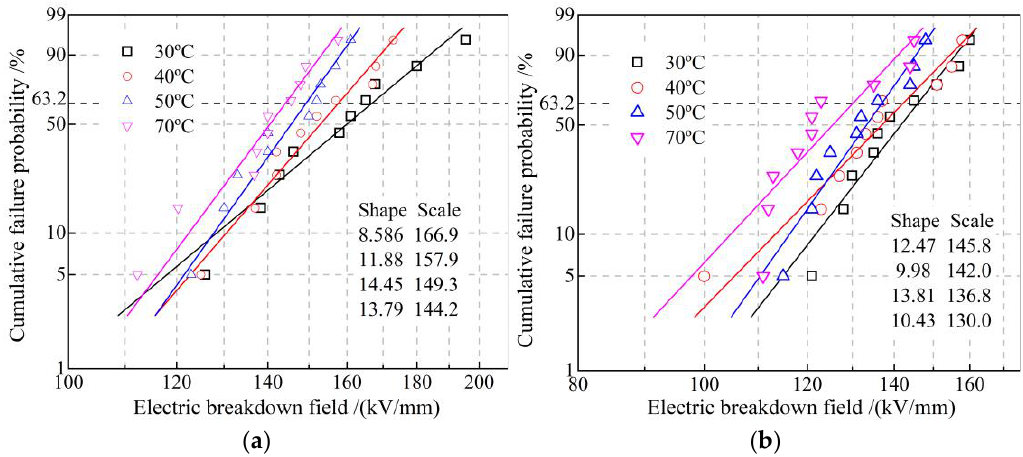
Figure 9. DC electric-breakdown fields fitted in Weibull statistics of ( a ) EPDM and (b ) EPDM-g-GMO at diverse temperatures from 30 to 70 °C.